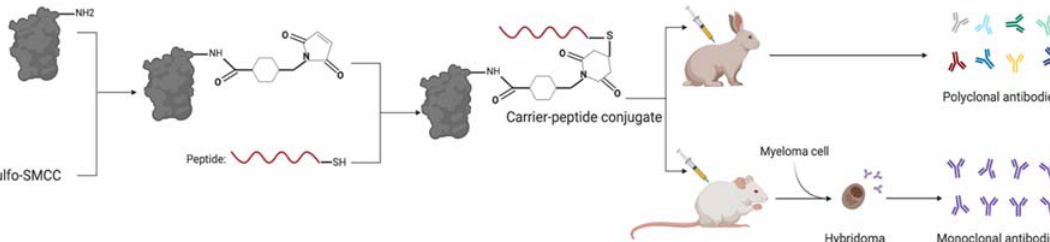
Figure 1. Example of a conventional targeted monoclonal and polyclonal antibody development process using conjugated peptides.